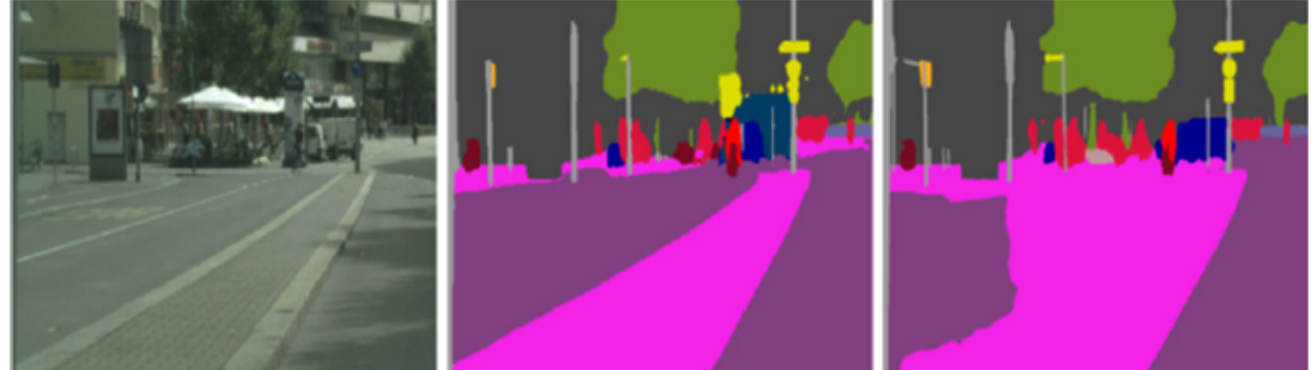
Figure 1. Failure case of a semantic segmentation task: input image ( left ); ground truth segmentation map ( middle ); and predicted segmentation map ( right